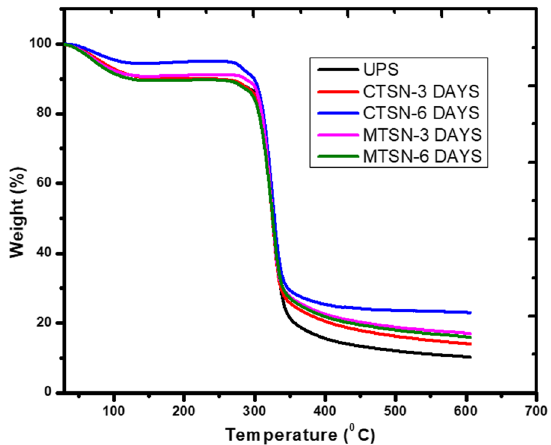
Fig. 3 The overlay of TGA curves obtained for UPS, CTSN-3 days, CTSN-6 days, MTSN-3 days, and MTSN-6 days during heating at a rate of 10 °C/min from 30 to 600 °C. The comparison of thermogravimetric analysis (TGA) curve of untreated potato starch (UPS) against chemically treated starch nanoparticle (CTSN) and mechanically treated starch nanoparticle